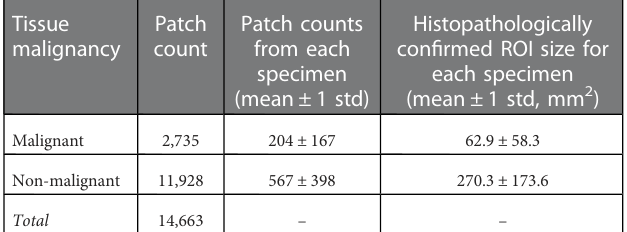
TABLE 2 Sampled patch counts (size of 1.8×1.8 mm 2 ) in the training set by tissue malignancy. Tissue